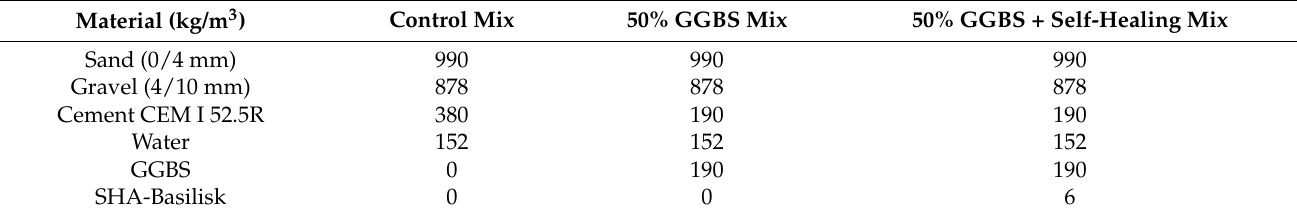
Table 1. Mix quantities—kg per cubic